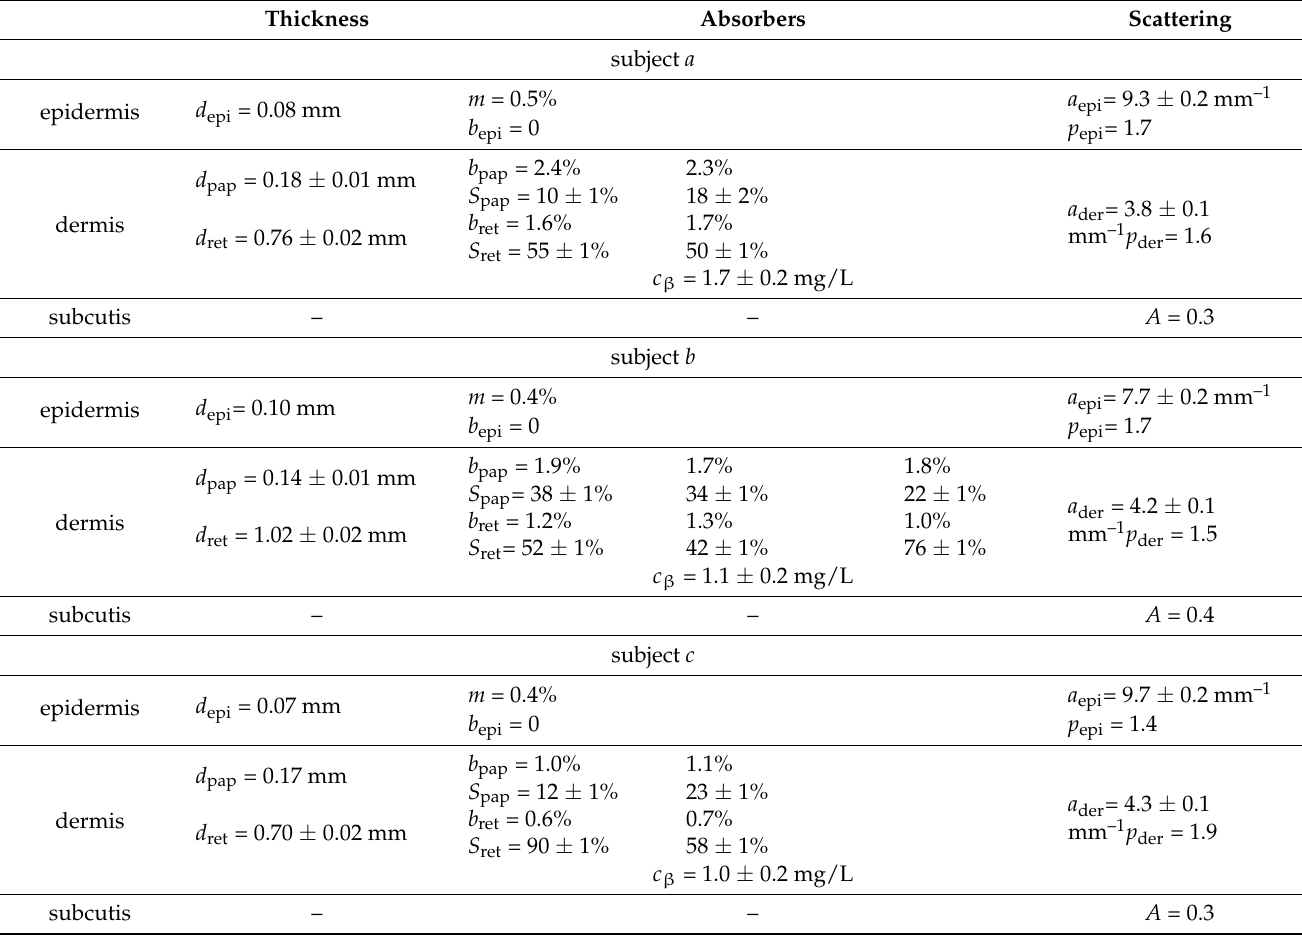
Table 2. Characteristics of the intact skin site in all three subjects assessed by simultaneous analysis of the data obtained on two or three consecutive days. The dermal blood contents ( b pap and b ret ) and oxygenation levels ( S pap and S ret ) were allowed to vary, while the remaining parameter values were linked together (for the definitions please see Section 2.3). The indicated intervals are standard deviations from 5 IMC runs (omitted when smaller than 1 on the last decimal place). Thickness Absorbers